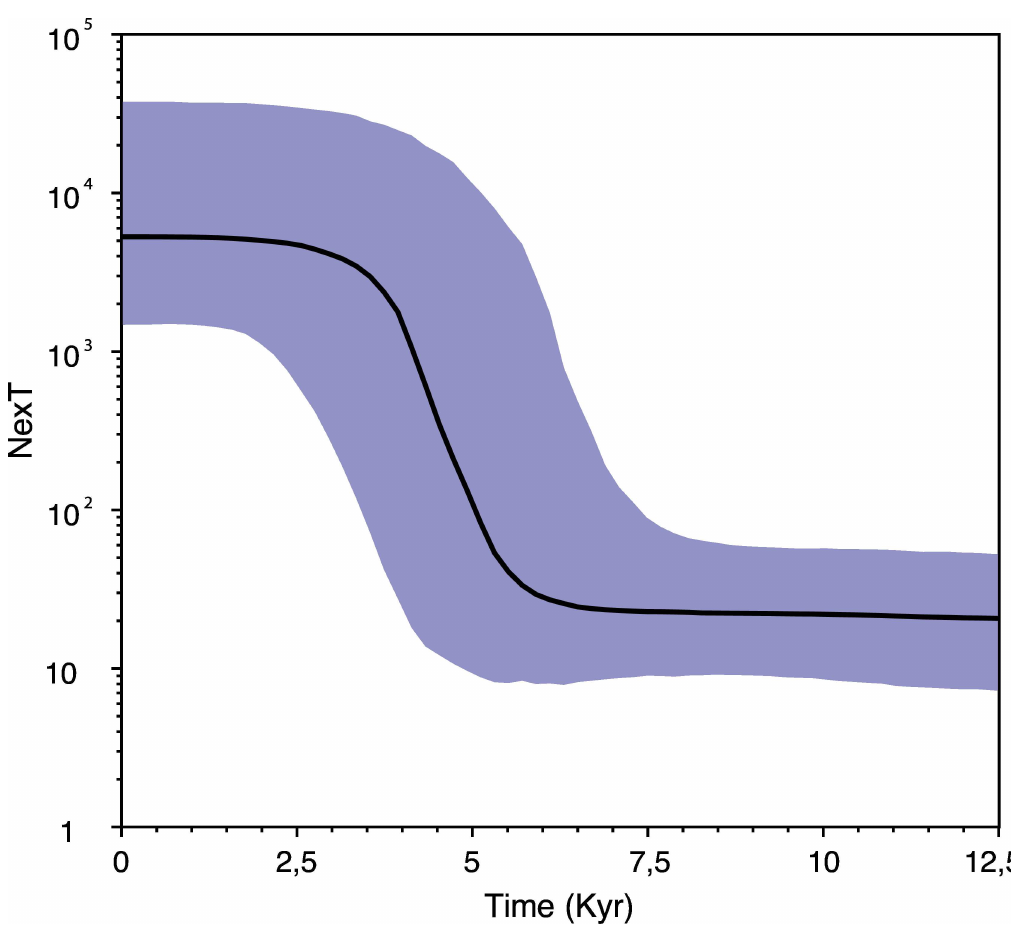
Fig 3. Bayesianskyline plot of temporal trends in effective population size of European ticks ( Ixodes ricinus ). The x-axis is given in thousandsof years before present and the y-axis gives the product of effective populationsize and generationtime (NexT). The black line represents the median estimate and the shaded area representsthe 95% highest posterior density